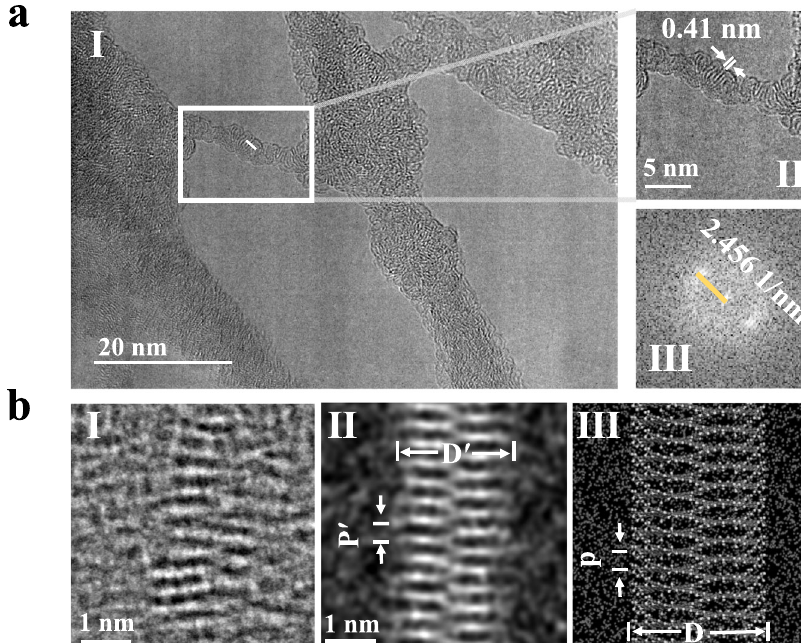
Fig. 5 HRTEM and iDPC-STEM characterizations of CNS. a (I) A HRTEM image showing the 2D helical self-assembled CNS. The experiment was carried out on JEM ARM-200F microscope operated at 200 kV. (II) An enlarged area HRTEM image of the white rectangle in (I). (III) The FFT pattern from the white rectangle in (I). b (I) Low-dose iDPC-STEM image showing the single-strand CNS. (II) Simulated projected potential (amorphous carbon substrate) of the CNS. A speci fi c point-spread-function (PSF) width of 1.5 Å was used for CNS. Statistical analysis of CNS samples shows that measured helical pitch ( p ′ ) and width ( D ′ ) values are mainly distributed at 0.40 ± 0.03 nm and 2.7 ± 0.2 nm, respectively. (III) structural model of the CNS. Statistical analysis shows that the helical pitch ( p ) and width ( D ) calculated by DFT are ~0.41 nm and ~2.88 nm, respectively (with alkyl